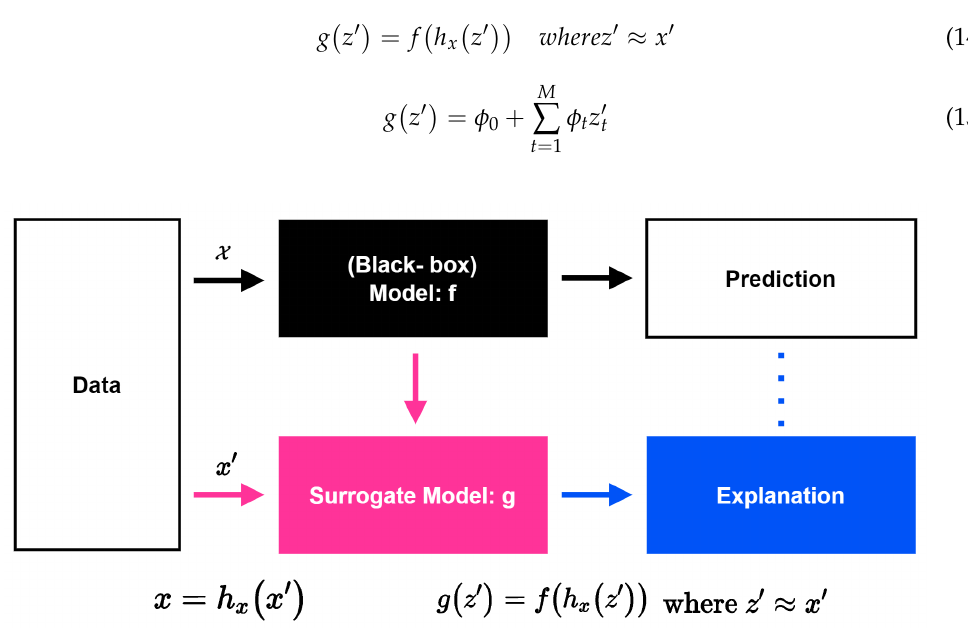
Figure 10. SHAP flow